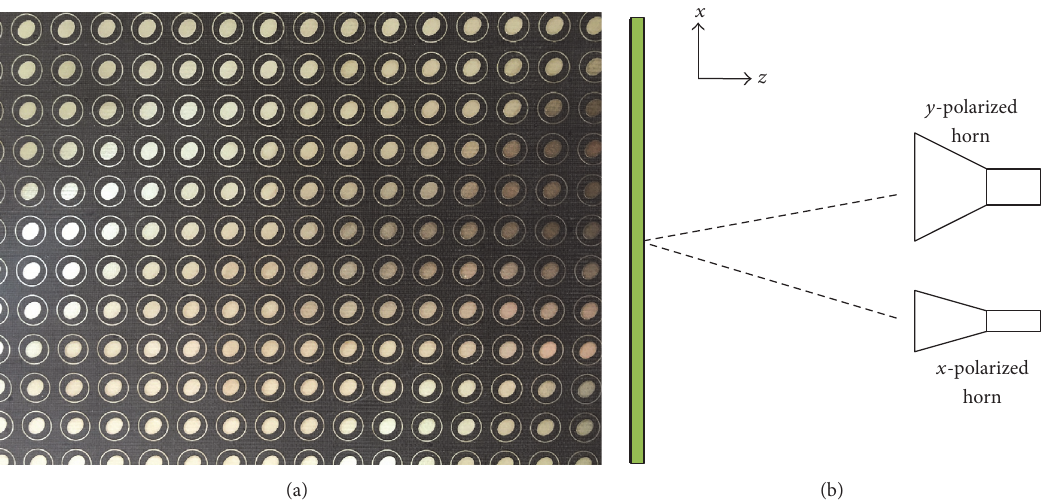
Figure 15: (a) Photo of the fabricated sample; (b) schematic of the